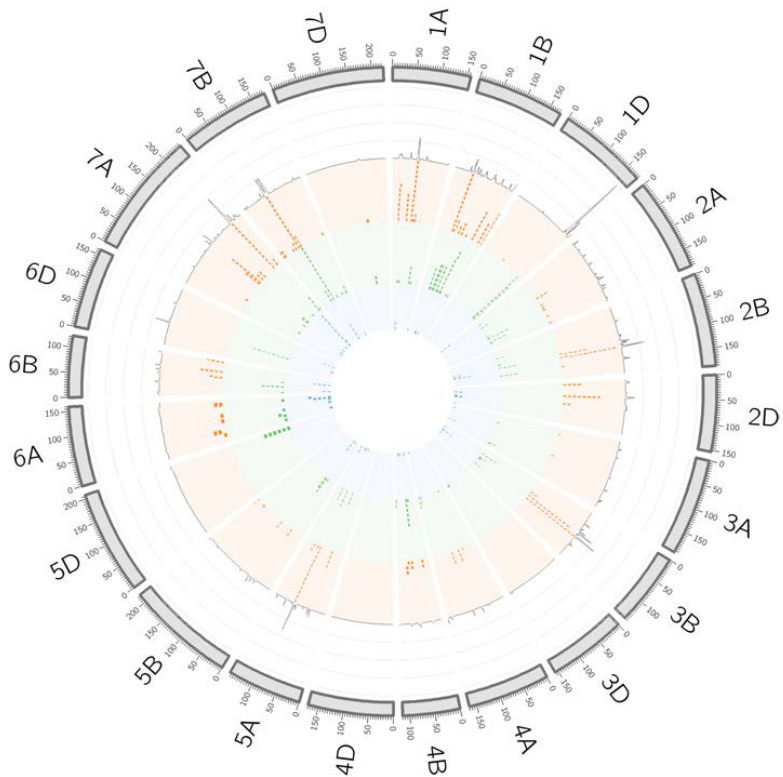
Figure 3. QTL overview index. The index values are represented along chromosomes as a grey line. Bars below the QTL overview index represent the significant MTAs (–log 10 p > 3). Orange, phenology MTAs; green, climatic MTAs; blue, eigen MTAs. These 69 peaks were reduced to 46 QTL hotspots (Table S5), 16 in genome A, 26 in genome B and 4 in genome D. To simplify the search for candidate genes (CGs), QTL hotspots were excluded when the CI was higher than 20 Mb (Table 3).